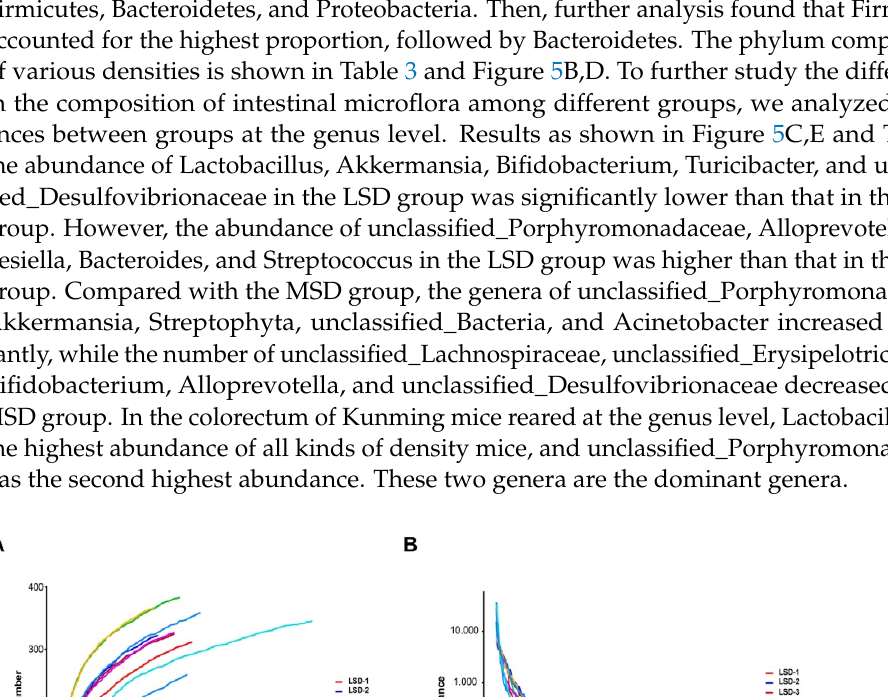
Figure 4. Analysis of gut microbial OTUs structures based on bacterial communities. ( A ) Rarefaction curves for sequencing of 16SrRNA in colorectal microflora. ( B ) Curves for diversity of samples by Rank-Abundance. Table 3. The bacterial abundance of Kunming mice fed with LSD, MSD, and HSD for 12 weeks in